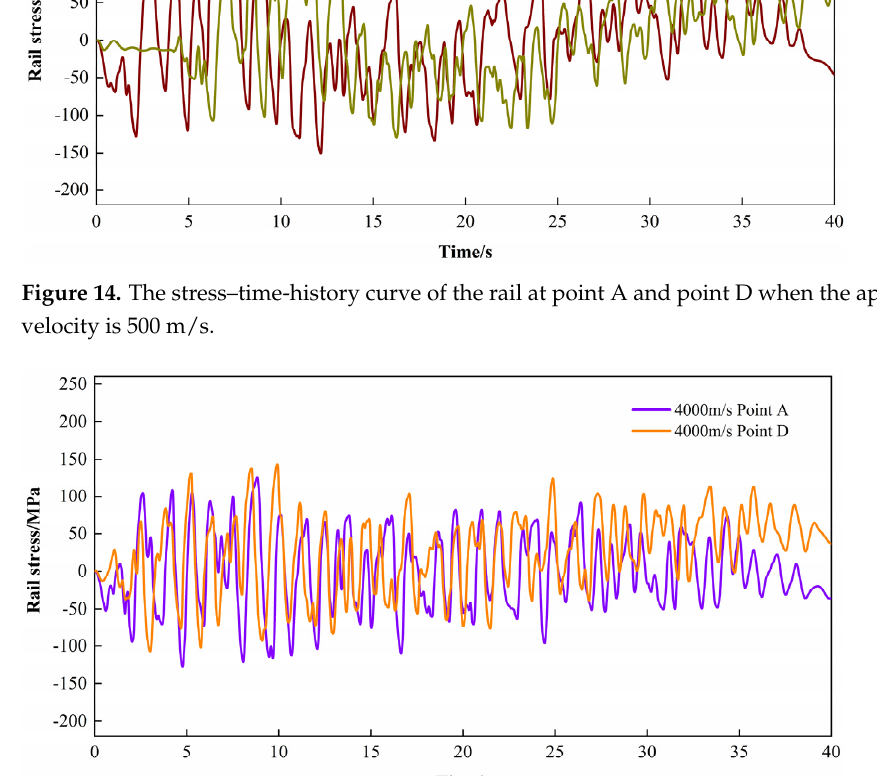
Figure 15. The stress–time-history curve of the rail at point A and point D when the apparent wave velocity is 4000 m/s.